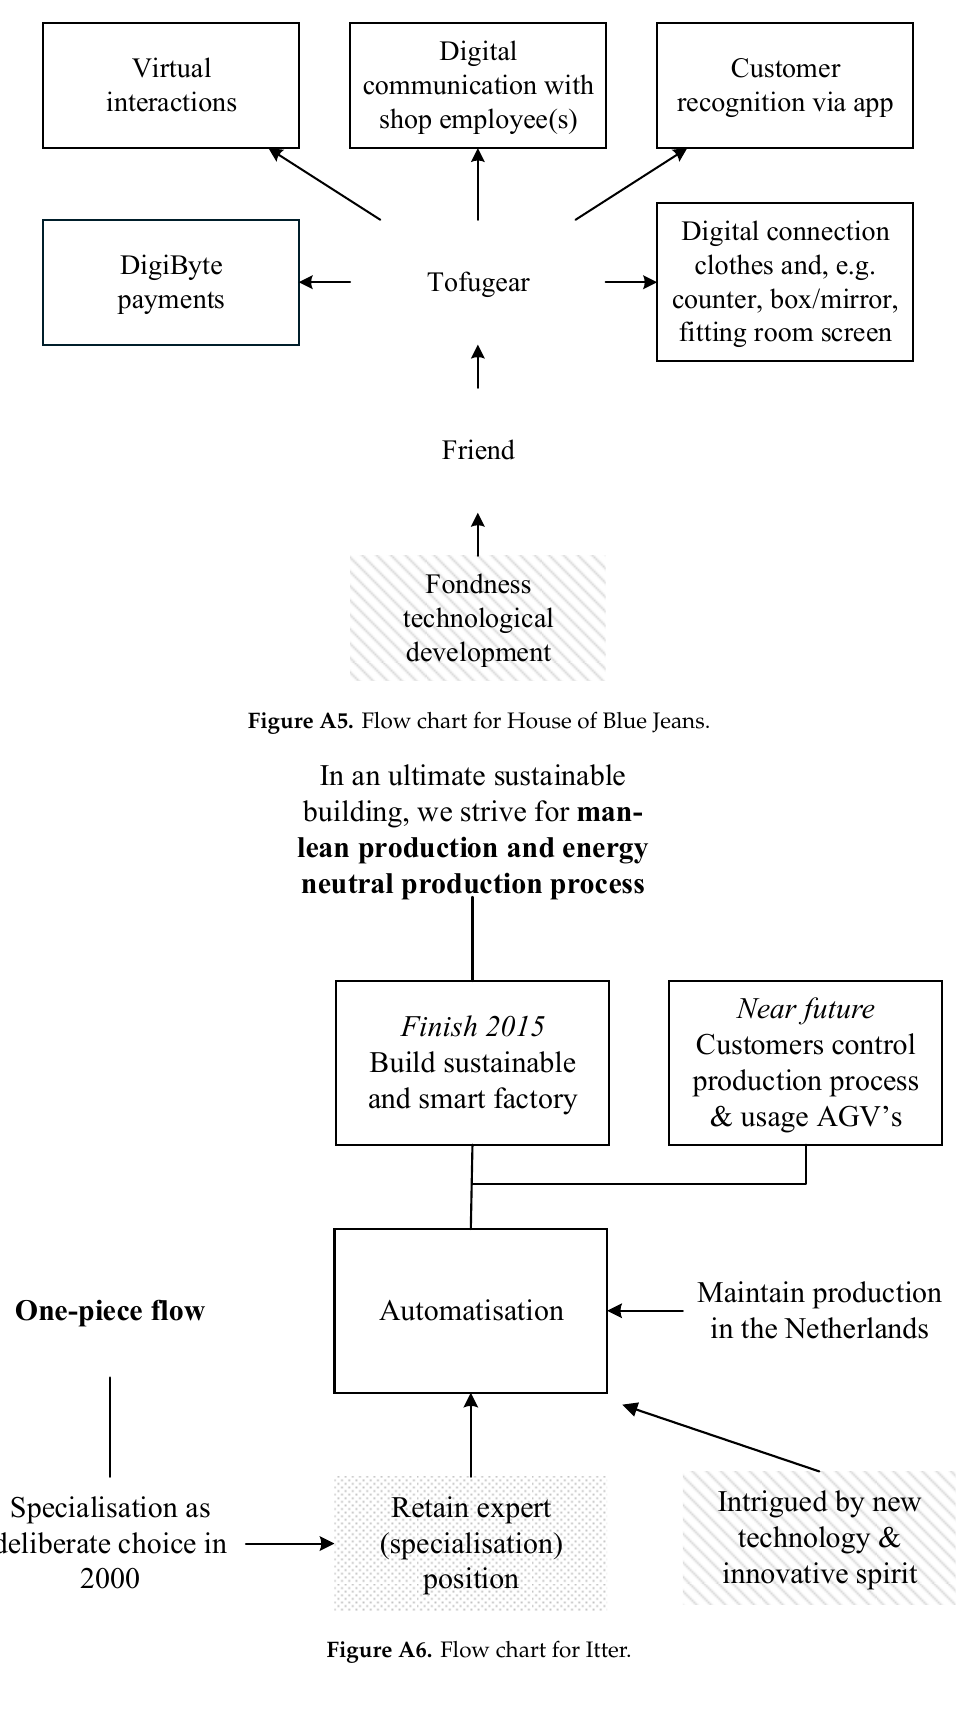
Figure A7. Flow chart for Kornelis Caps and Closures.